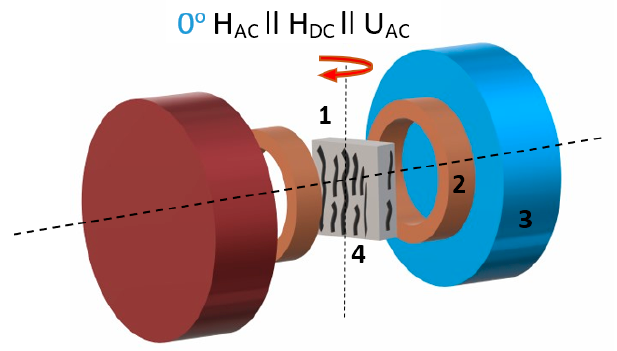
Figure 2. Scheme of the experiment for direct magnetoelectric (ME) measurements ( 1 —sample, 2 —Helmholtz coils, 3 —DC magnetic field source, 4 —aligned chains of particle clusters); the red arrow indicates the direction in which sample was rotated.